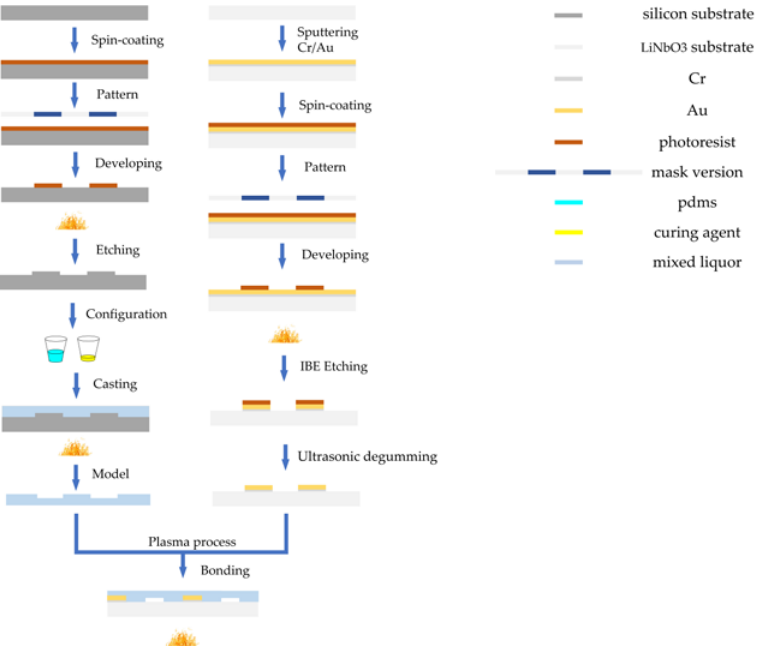
Figure 4. Flow chart of microfluidic chip manufacturing